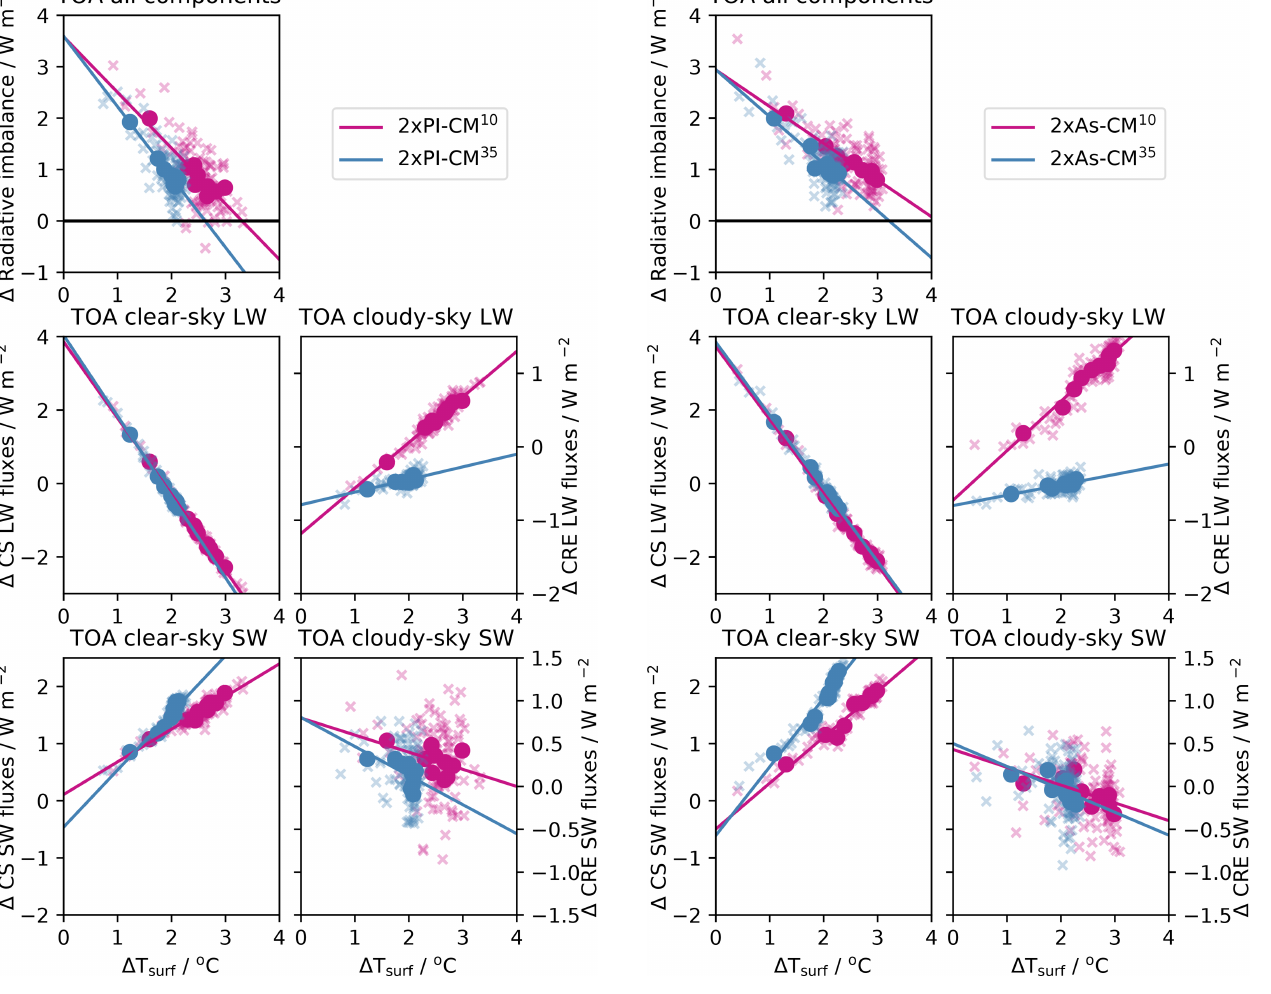
Figure 9. Gregory analysis of HadCM3-BL: regression of top- of-atmosphere radiative imbalance against surface air temperature change (solid lines) for the first 100 years of 2 × PI-CM 10 (pink) and 2 × PI-CM 35 (blue) cases. Annual averages are indicated by crosses and decadal averages are indicated by filled circles. The re- gression was performed on the decadal averages.